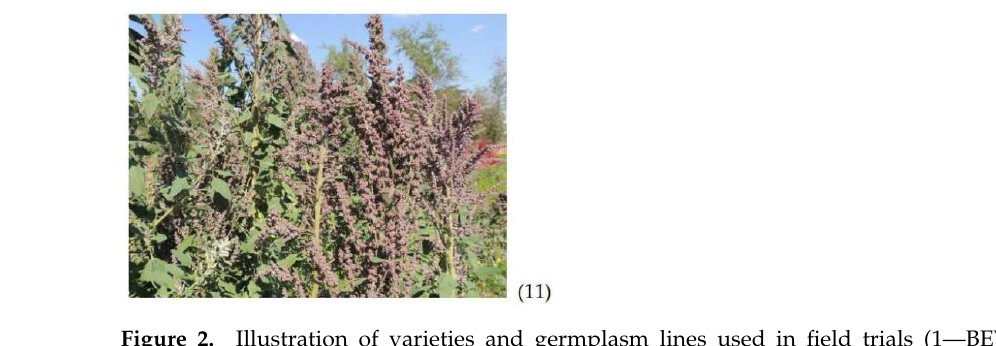
Table 5. Flowering time (days from planting to flowering) of varieties and germplasm lines at selected trial sites.